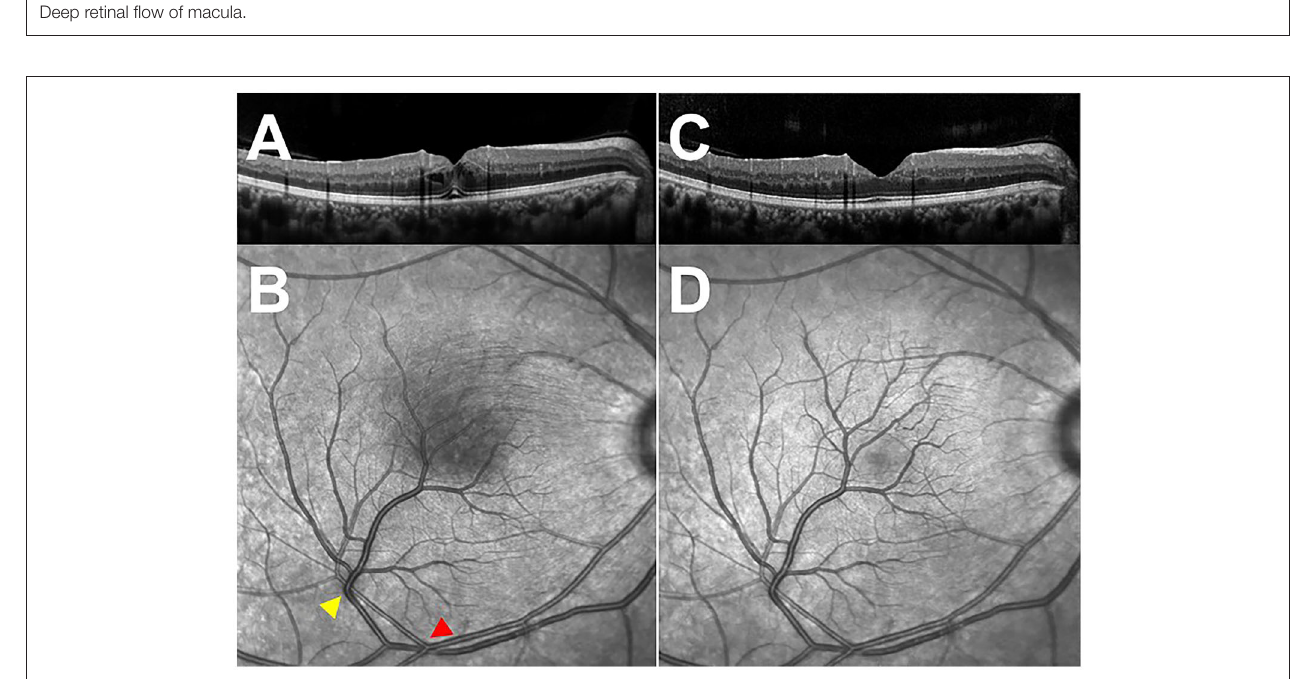
FIGURE 2 | The 3 x 3mm optical coherence tomography angiography images of the macula. (A) Total retinal flow of macula. (B) Superficial retinal flow of macula. (C) Deep retinal flow of macula.